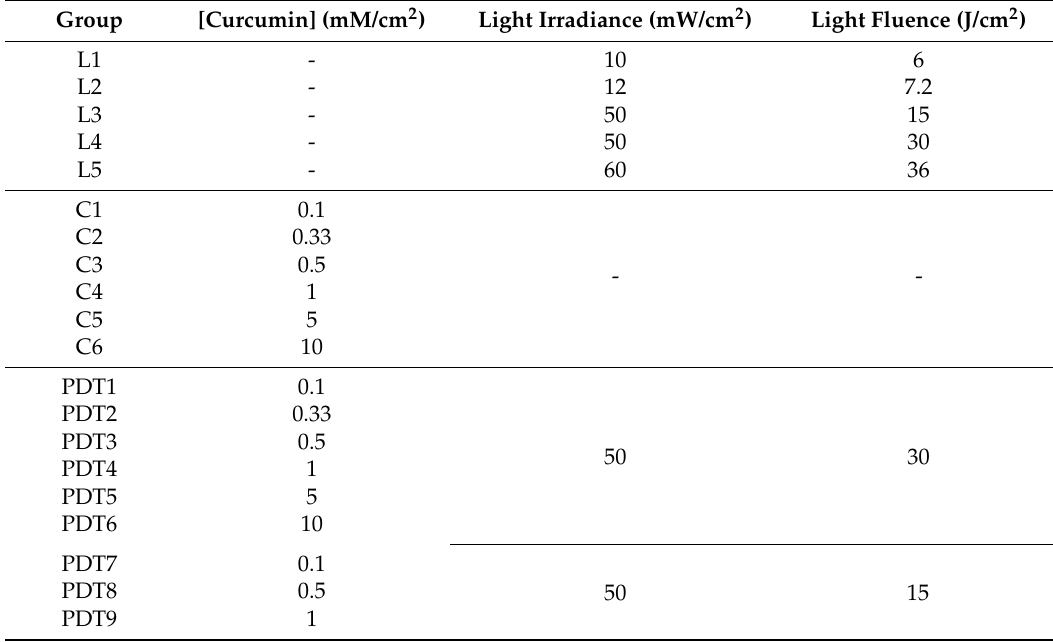
Table 1. Description of the experimental